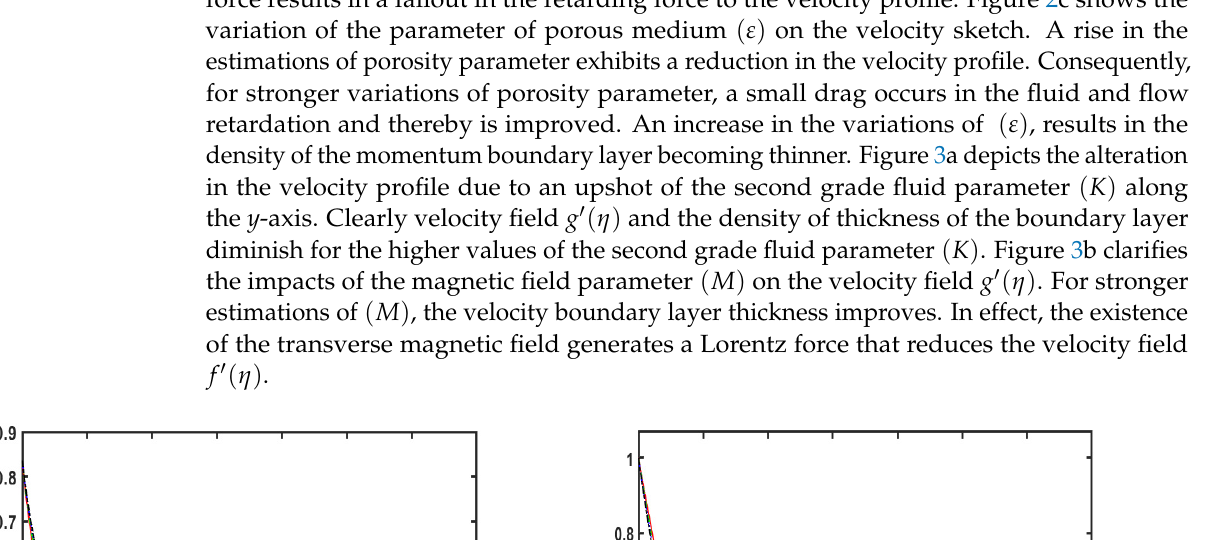
( b ) ( c ) Figure 3. ( a – c ): Variation in 𝐾, 𝑀 and 𝜀 against 𝑓′(𝜂) , respectively.